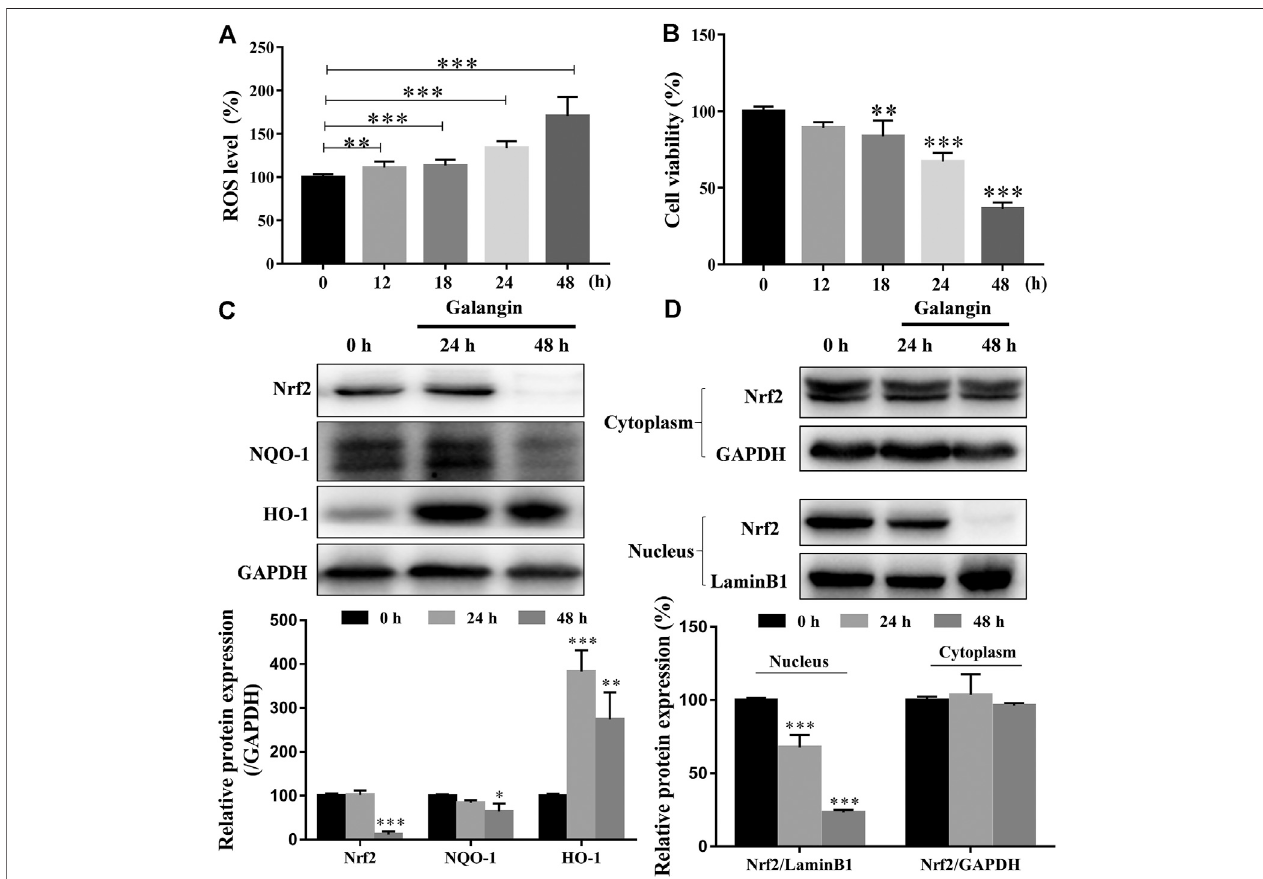
FIGURE 7 | Galangin enhances ROS accumulation and reduces activation of Nrf2-mediated antioxidant system in MGC 803 cells. (A – B) Galangin (20 μ M) promoted ROS levels in MGC 803 cells after treatment for 12, 18, 24, and 48 h. (C) Galangin (20 μ M) reduced protein expression of Nrf2 and NQO-1, and enhanced protein expression of HO-1 after treatment for 48 h in MGC 803 cells. (D) Galangin (20 μ M) inhibited Nrf2 translocation into nucleus of MGC 803 cells after treatment for 48 h. All of the data were shown as mean ± SD, and differences among ≥ 3 groups were analyzed by one-way ANOVA with Dunnett test by using GraphPad 7.0 software; ** p < 0.01; *** p < 0.001, compared with control group. n ≥